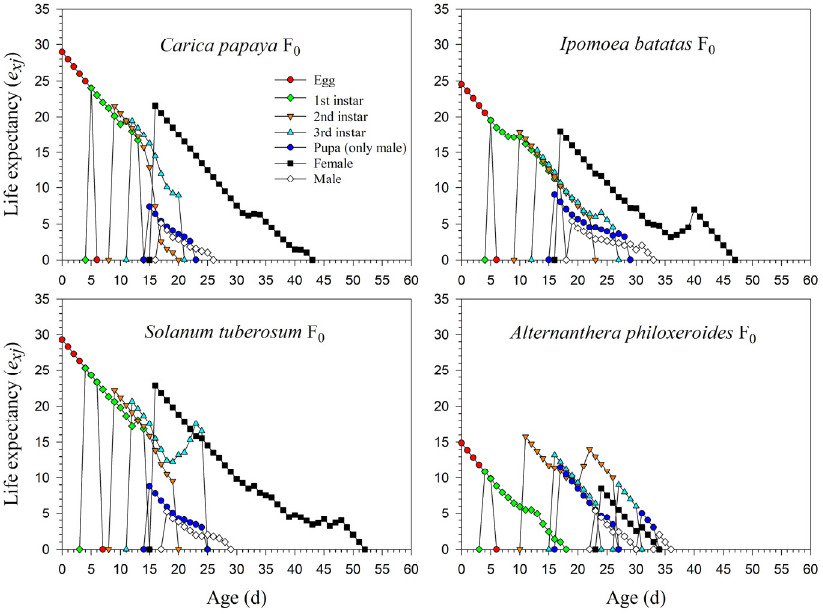
Figure 5. Age-stage-specific life expectancy ( e xj ) rates of Paracoccus marginatus individuals reared on four different host plants (F 0